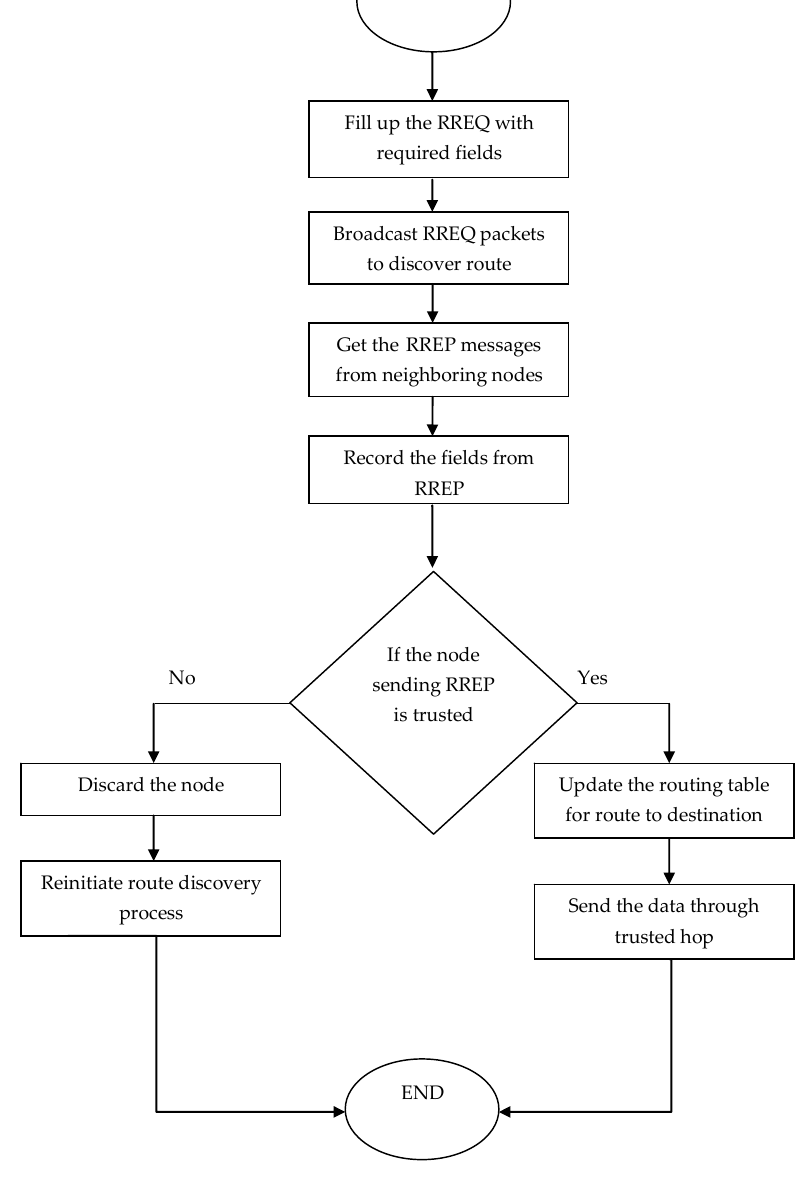
Figure 4. Trust based secure Qulaity of Service (QoS) routing strategy.